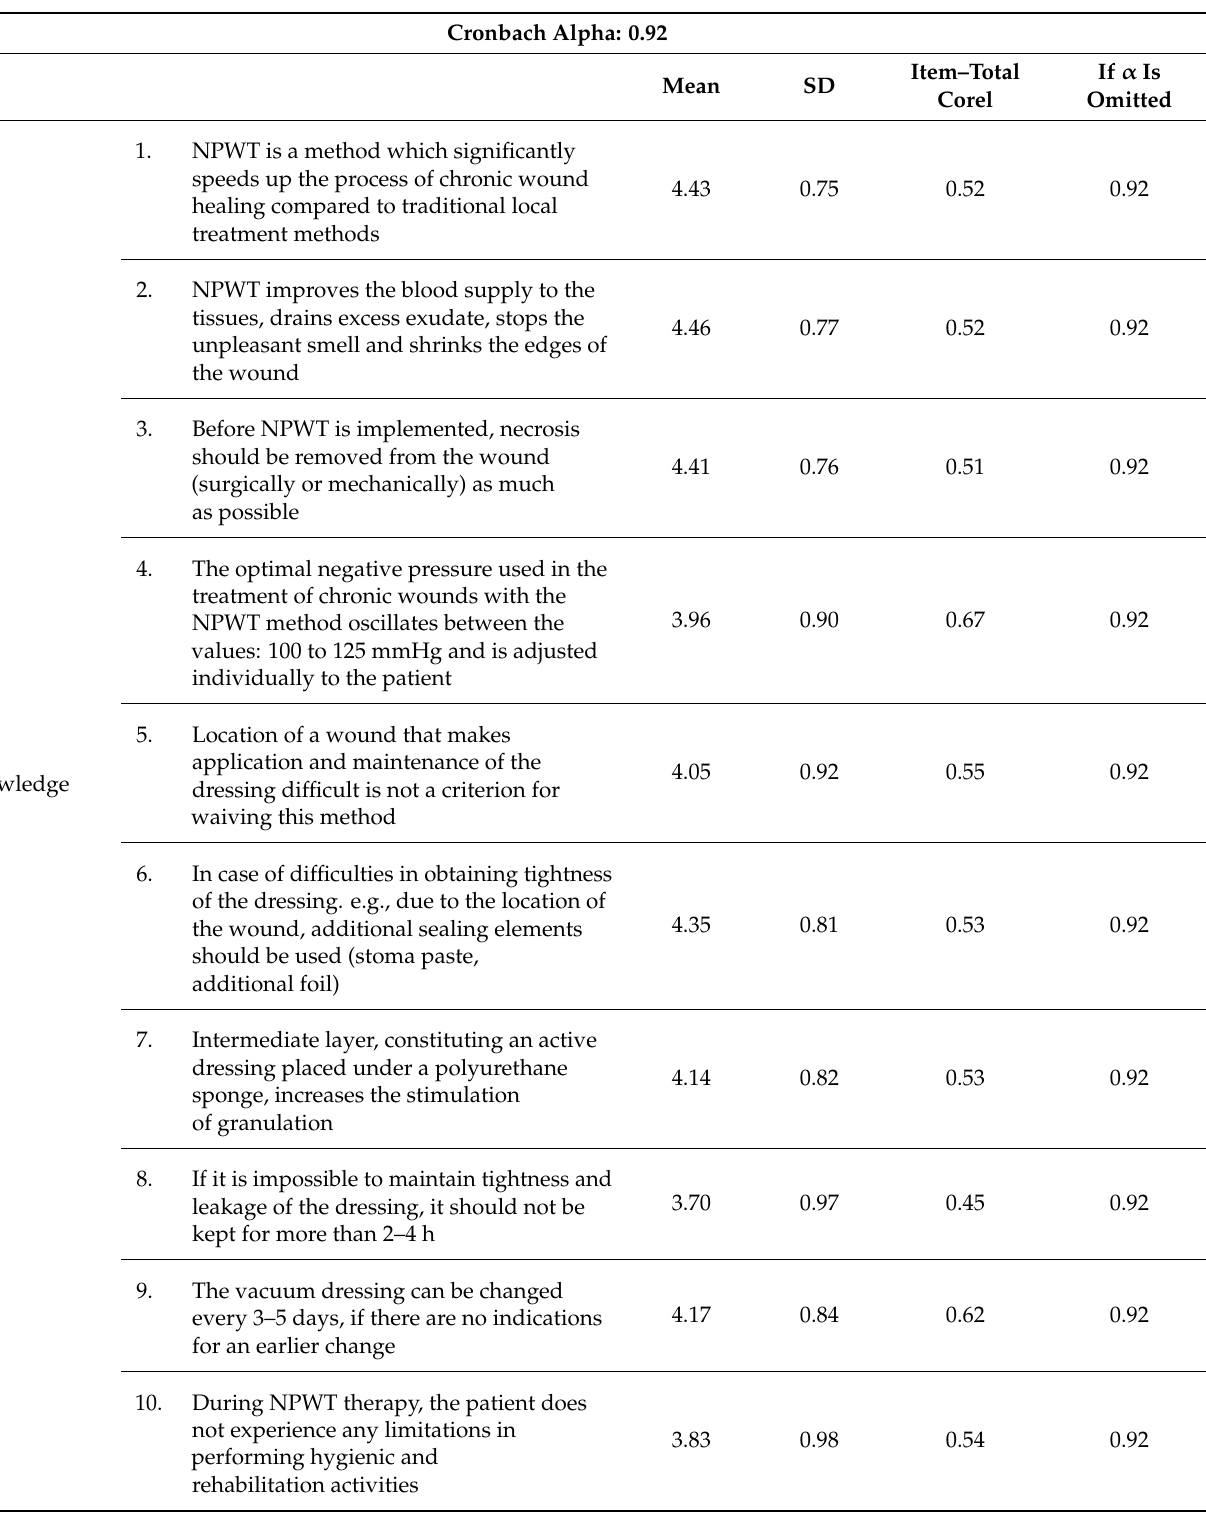
Table 1. NPWT perception questionnaire